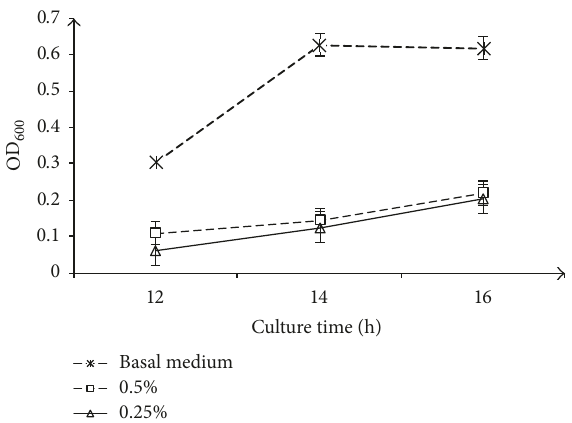
Figure 3: The influence of different concentrations of oligosaccha- ride from acid hydrolysis of jujube polysaccharides on strain J- 4 intestinal probiotics (bacterial growth determined by measuring OD600 nm at 12h, 14h, and 16 h into the culturing period). Values represent the mean of at least three biological replicates ± standard error of the mean.